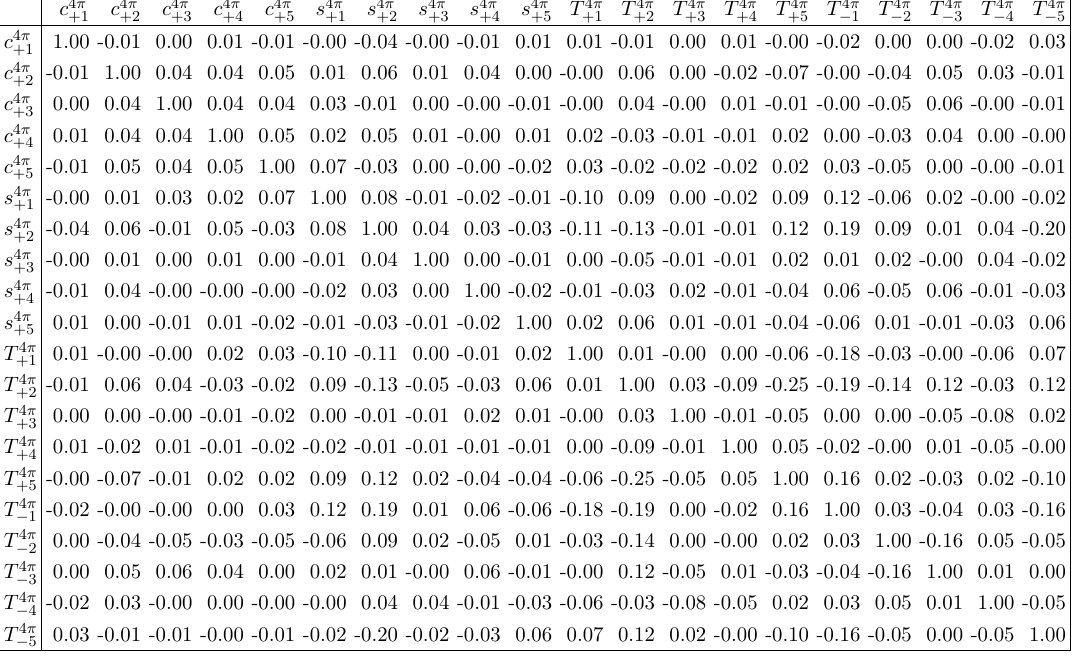
Table 9 . The statistical and systematic correlations between the 4 (cid:25) (cid:6) hadronic parameters using the equal (cid:1) (cid:14) 4 (cid:25) binning scheme with N = 5. p